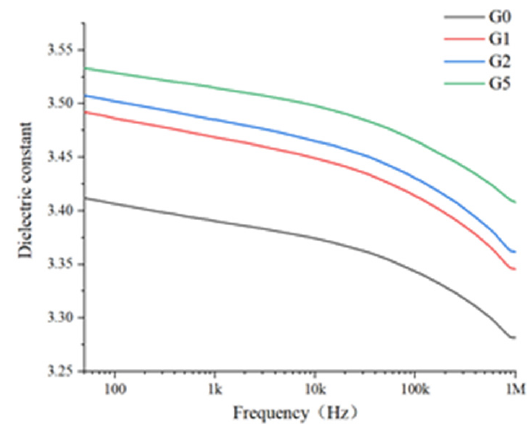
Figure 7. Relative permittivity of the films.